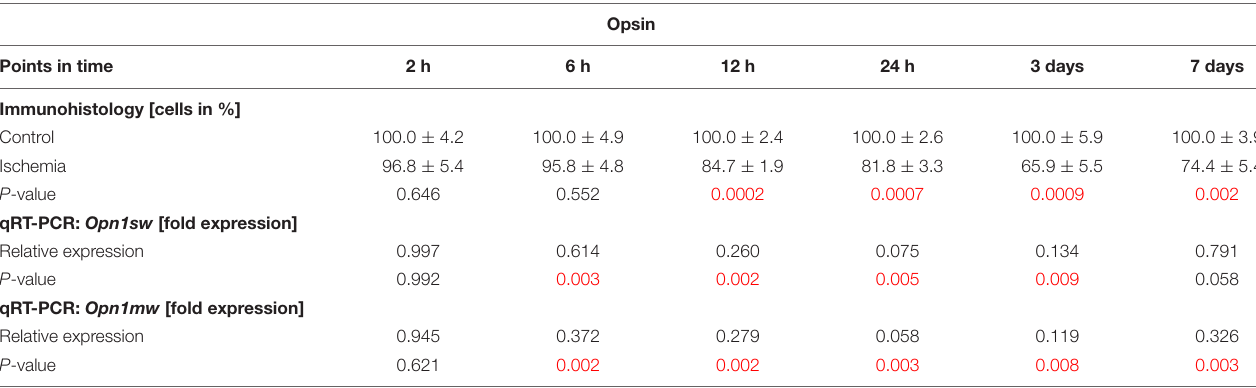
TABLE 8A | Analyses of the opsin staining (%) at all points in time.